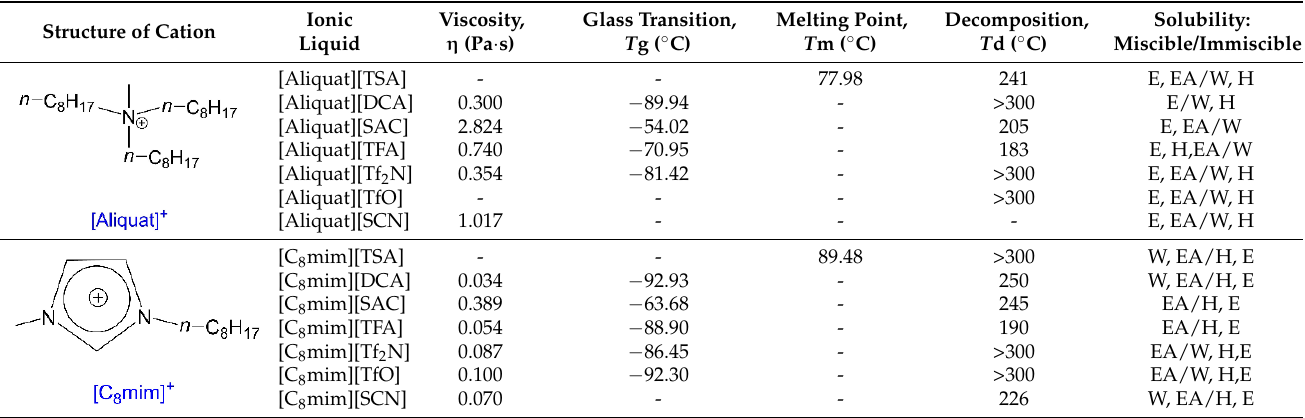
Table 2. Comparison of some selected properties for ionic liquids with [Aliquat] + and [C 8 mim] + cations [11].